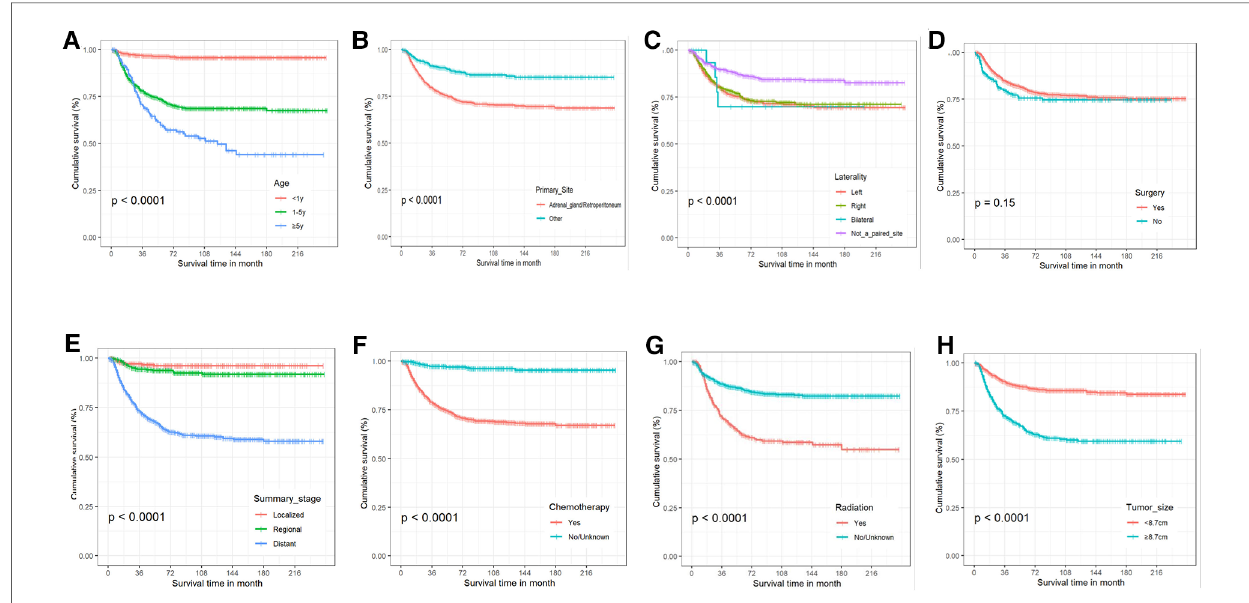
FIGURE 3 The Kaplan-Meier curves for cancer-speci fi c survival. ( A ) Age. ( B ) Primary tumor site. ( C ) Tumor laterality. ( D ) Surgery. ( E ) Summary stage. ( F ) Chemotherapy. ( G ) Radiotherapy. ( H ) Tumor